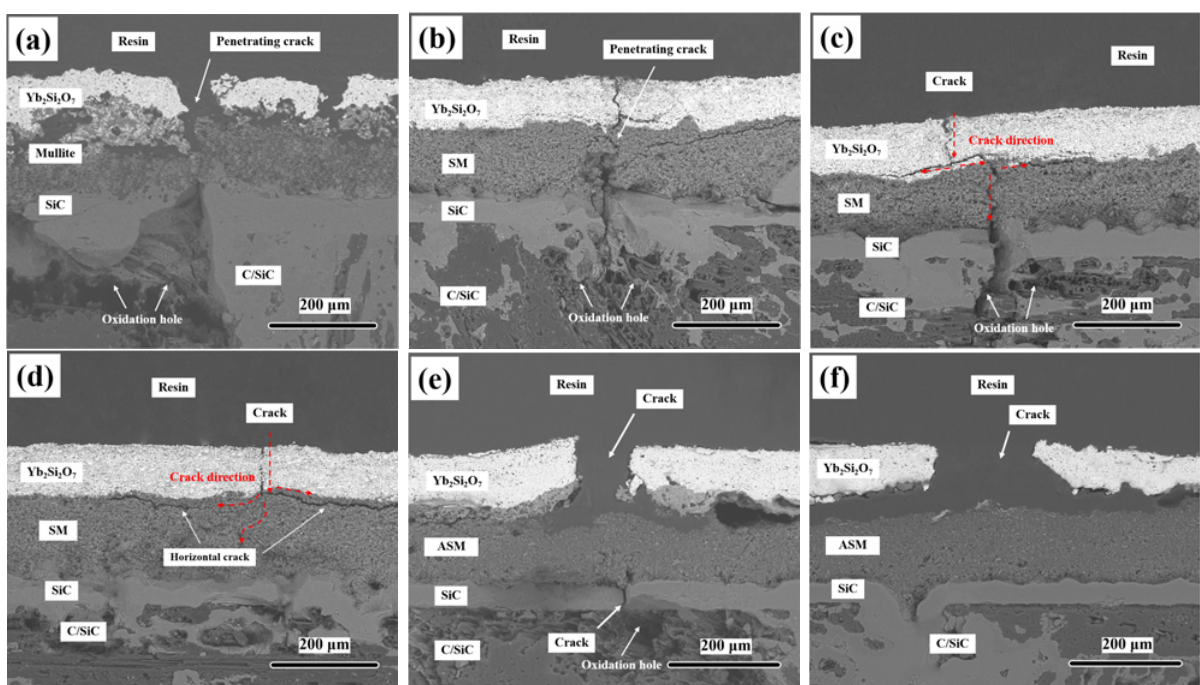
Fig. 9 Cross-section microstructures of tri-layer (a) Yb 2 Si 2 O 7 /mullite/SiC, (b–d) Yb 2 Si 2 O 7 /SM/SiC, and (e, f) Yb 2 Si 2 O 7 / ASM/SiC coatings-coated C f /SiC samples after 360-min corrosion in the burner rig test at 1673 K.